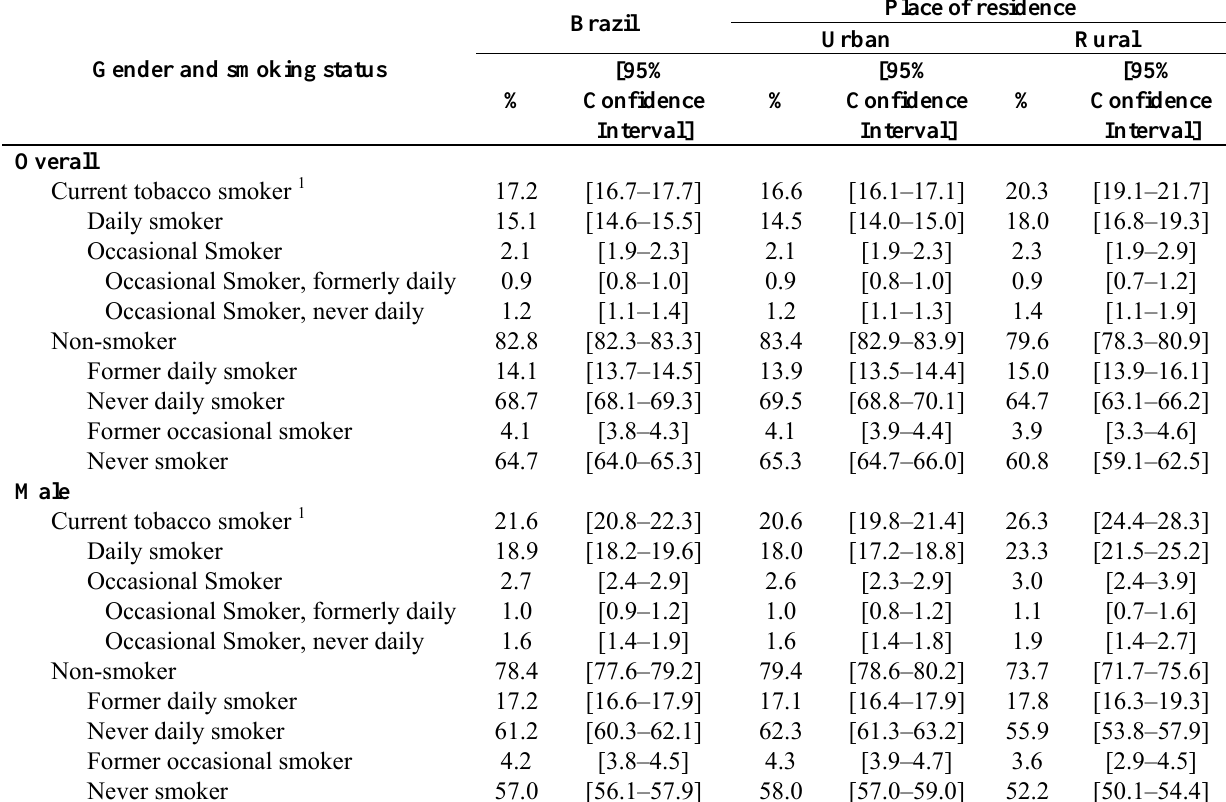
Table 2. Percentage of adults ≥ 15 years old, by place of residence, gender and smoking status, GATS Brazil,